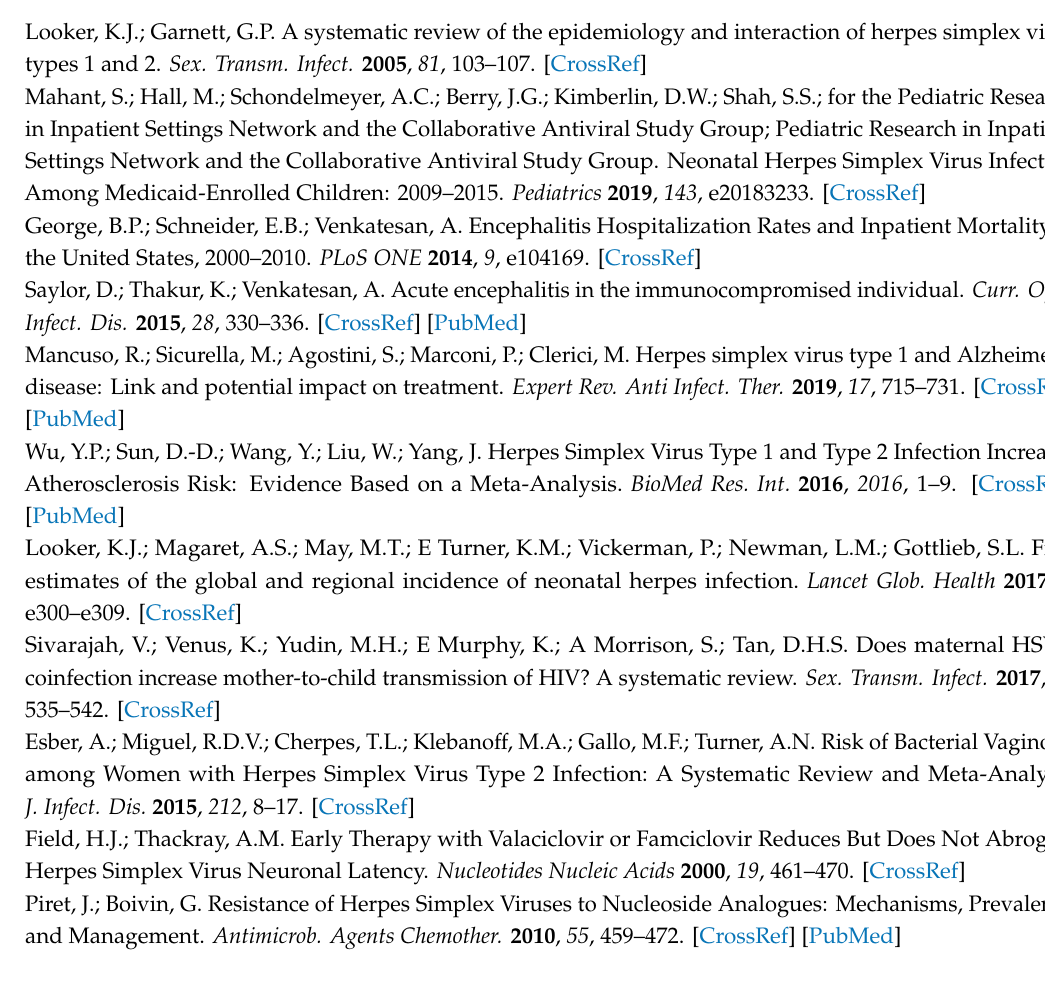
Figure S1: Tat exerts therapeutic e ff ects on previously acquired HSV-1 infection, Figure S2: Anti-Tat antibodies do not interfere with HSV-1 replication, Figure S3: Correlation between HSV-1-specific CD8 + T cells, e ff ector memory (EM) CD8 + T cells and HSV-1-specific humoral